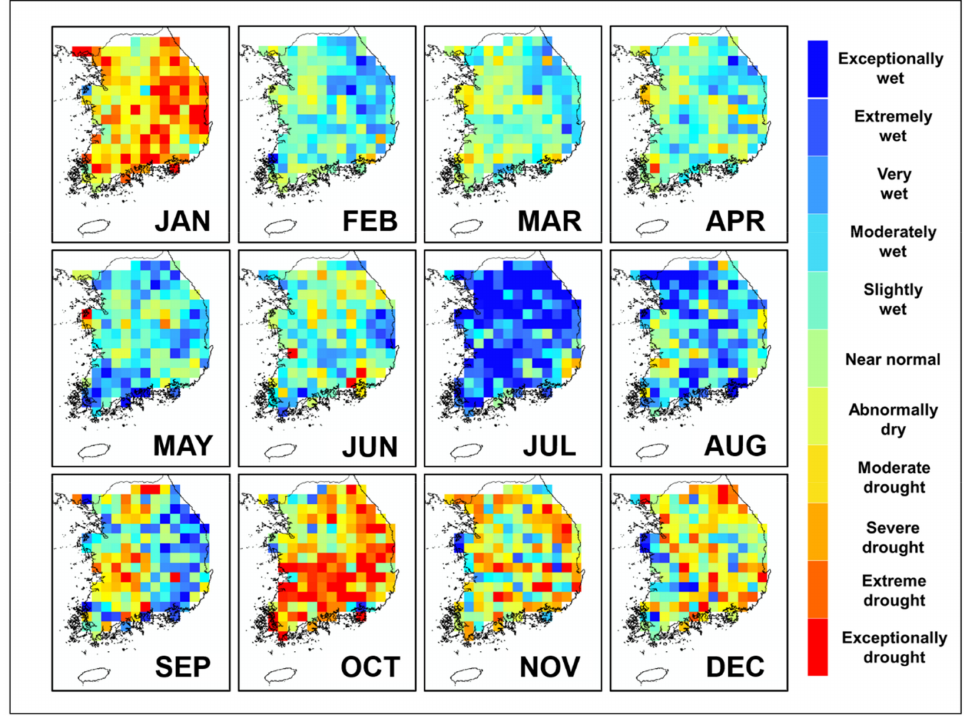
Figure 8. Spatial distribution of SGI using multi-satellite data with ANN